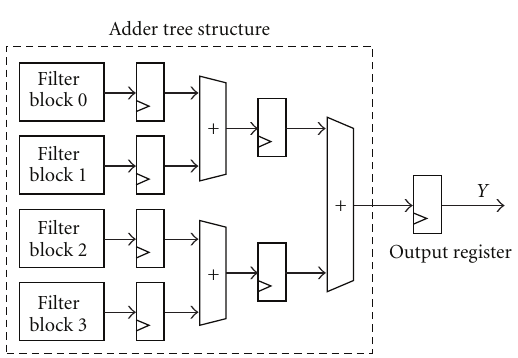
Figure 5: Adder tree structure for filter blocks’ outputs. M/L = 4. Table 6: DPR system throughput (MSPS) as function of delay between reconfigurations for 1D fir filtering with full filter recon-